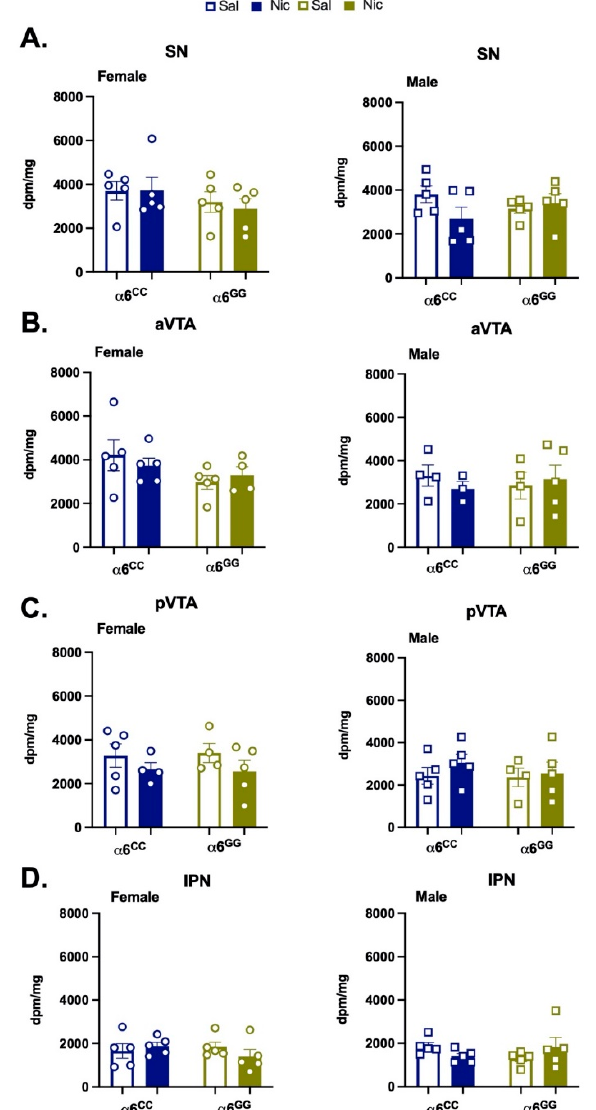
Figure 5. Nicotine does not alter α 6 nicotinic receptor subunit mRNA expression in humanized CHRNA 6 3 ′ -UTR SNP Rats. Mean dpm/mg ± SEM for sub-chronic nicotine exposed male and female rats in the ( A ) substantia nigra (SN), ( B ) anterior ventral tegmental area (aVTA), ( C ) posterior ventral tegmental area (pVTA), and ( D ) interpeduncular nucleus (IPN), n = 3–5/group. Saline (Sal), Nicotine (Nic). Circles represent females, and squares represent males.